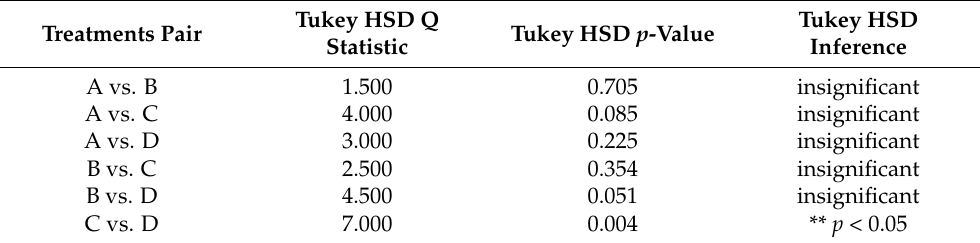
Table 7. Tukey results for pairwise comparison of treatments on infiltration